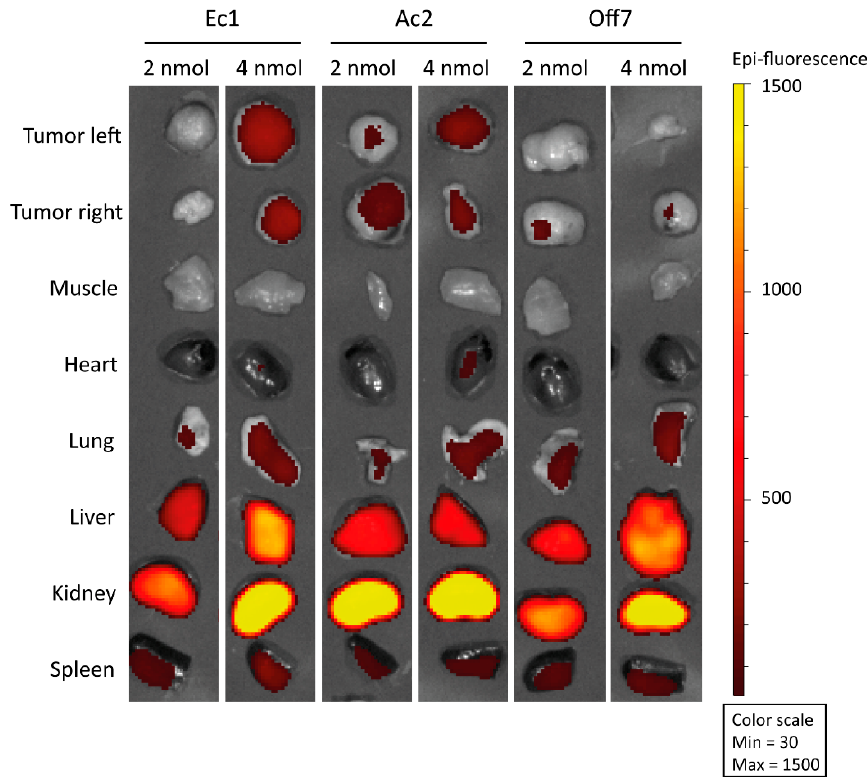
Figure 5. Visualization of IRDye 700DX-derived fluorescence in OV90 tumors and organs harvested from mice at 4 h after intravenous injection with either 2 or 4 nmol of the various DARPin-IRDye 700DX conjugates.